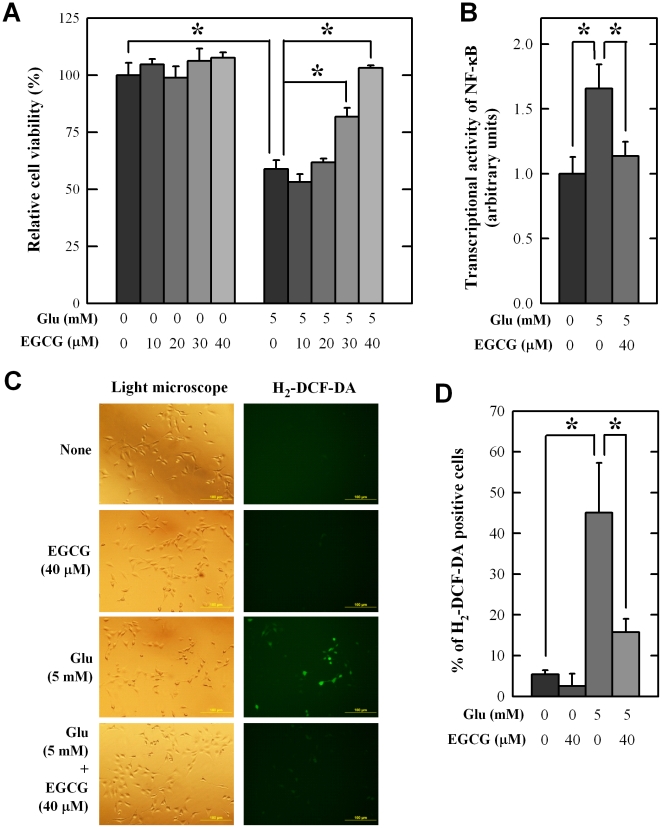
Protective effects of EGCG against glutamate-induced HT22 cell death.
A. Cell viability. B. Transcriptional activity of NF-κB. C. ROS generation. D. Percentage (%) of H2-DCF-DA-positive cells. HT22 cells were treated with 5 mM glutamate and/or EGCG at indicated concentrations. Cell viability, transcriptional activity of NF-κB, NF-κB subcellular localization, and ROS accumulation were determined as described in the Materials and Methods. The experiment was repeated at least 3 times. DAPI staining was employed as a nuclear counter stain. Vertical bars indicate standard deviation (S.D., N = 5). * P<0.05 compared to glutamate-treated group.